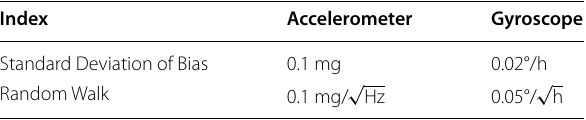
Table 2 Specification of the IMU used in the first field